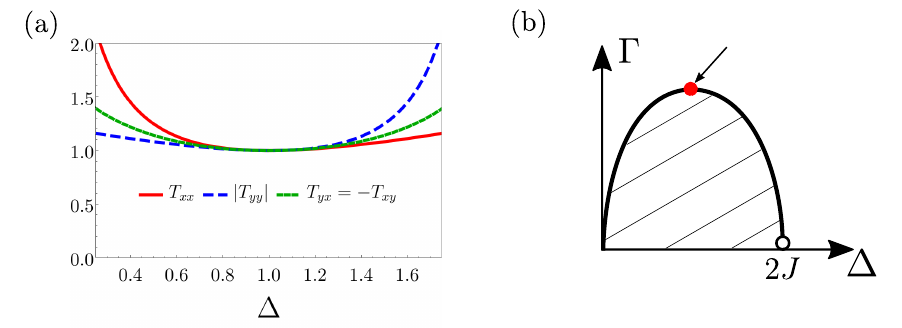
Figure 1: (a) Effective temperatures T , T , T and T as a function of ∆ at or xx x y yx y y away from the phase boundary; we choose the parameters J = 1, Γ = 4 with the point ∆ = 1 representing the critical point at the tip of the phase boundary (see the red dot in panel (b)). The effective temperatures become equal up to a sign at the critical point. The same pattern emerges on any point along the phase boundary and away from Γ = 0. (b) The phase diagram of the DDIM. The shaded region is the 〉 (cid:54) = ordered phase where 〈 ˆ S x , y